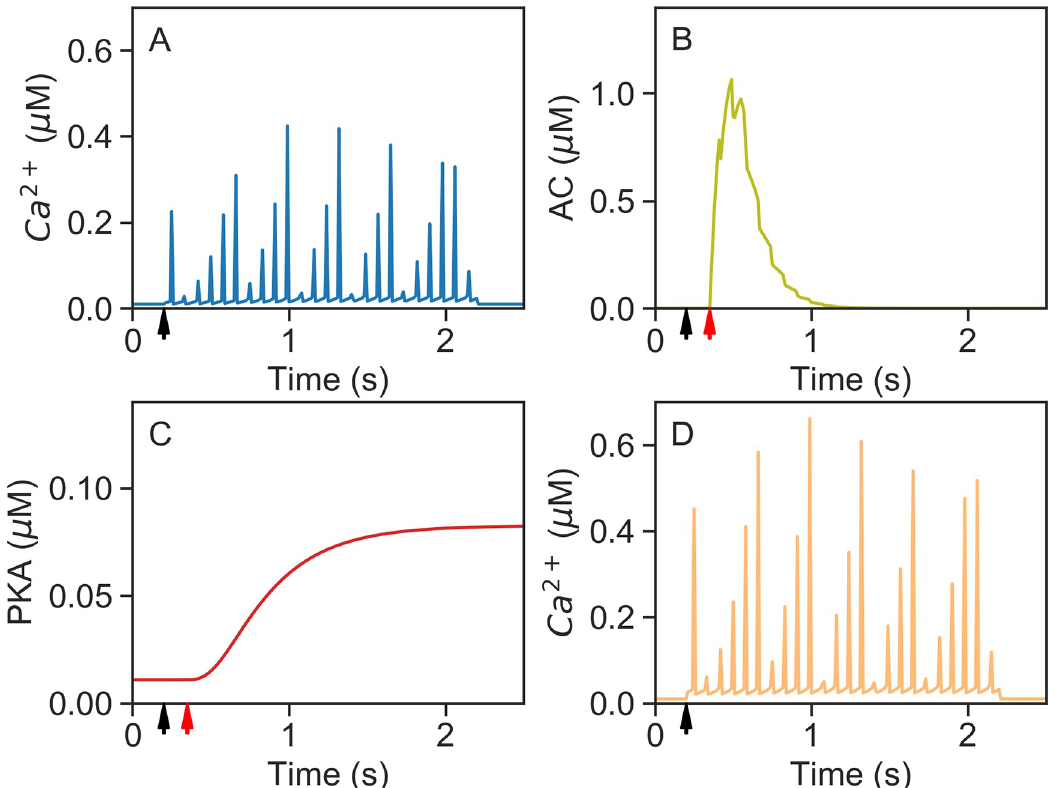
Fig 4. One pairing of CS-US with 150 ms inter-stimul us interval. Black arrow: parallel fiber input. Red arrow: climbing fiber input. (A) Calcium released for one CS-US pairing, (B) adenylyl cyclase evolution, and (C) PKA level, during the first pairing. (D) Calcium released during a second